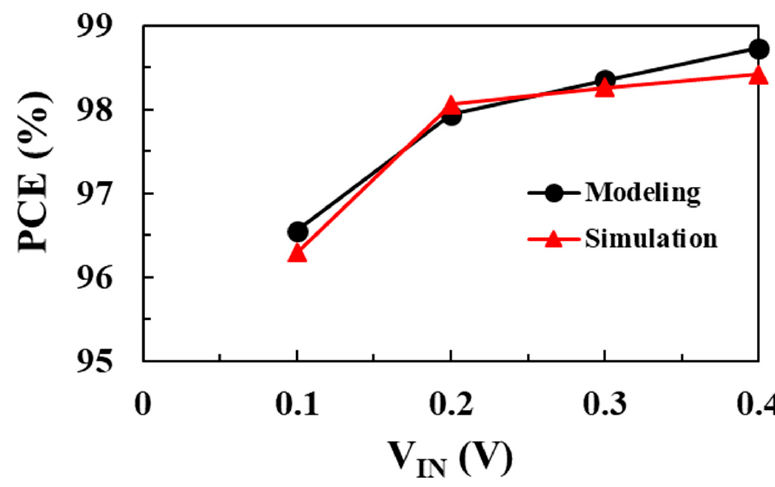
Figure 19. PCE according to input voltage comparison with the modeling results.